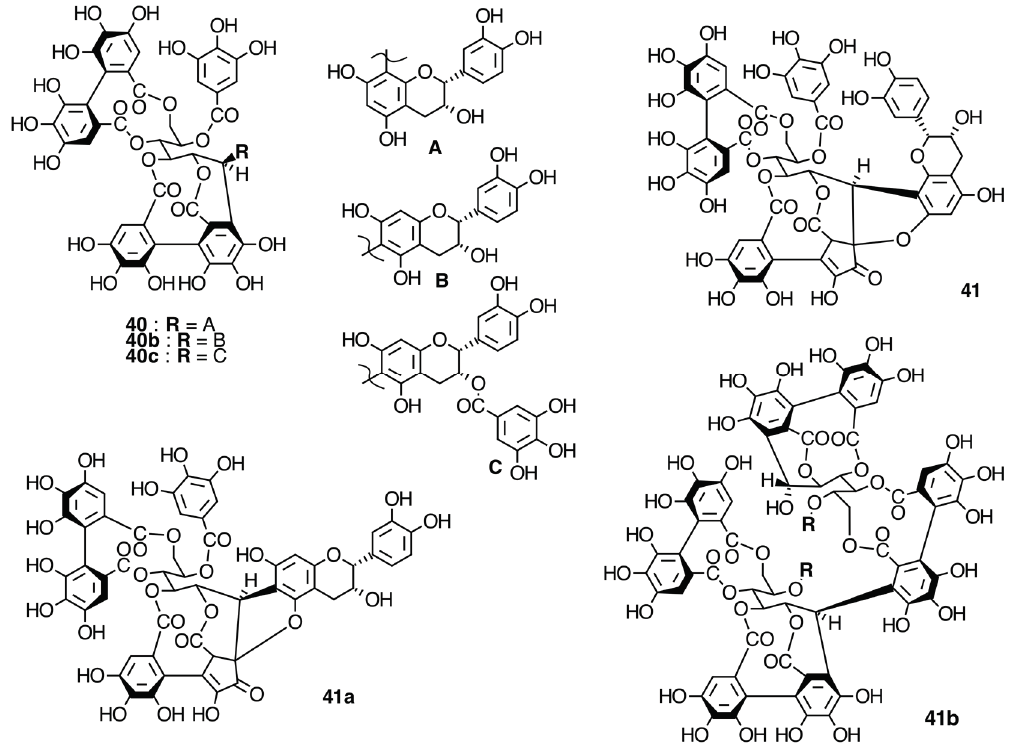
Figure 17. Complex tannins isolated in Melastomataceae